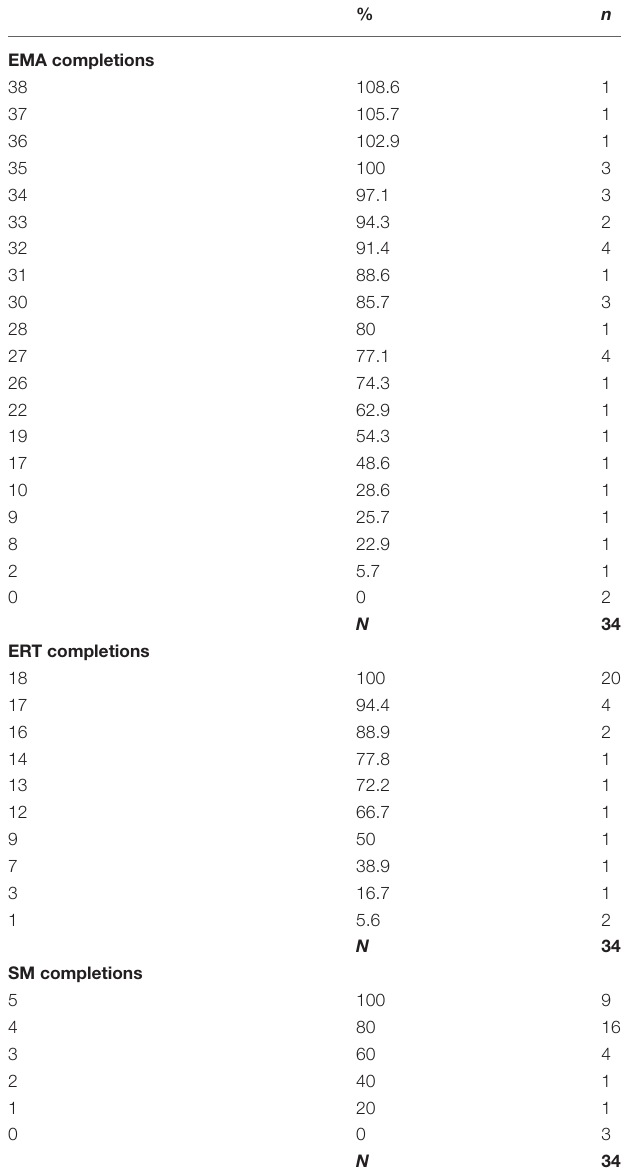
TABLE 5 | Number of completed surveys or program content for the ecological momentary assessment (EMA), emotion regulation training (ERT), and self-monitoring